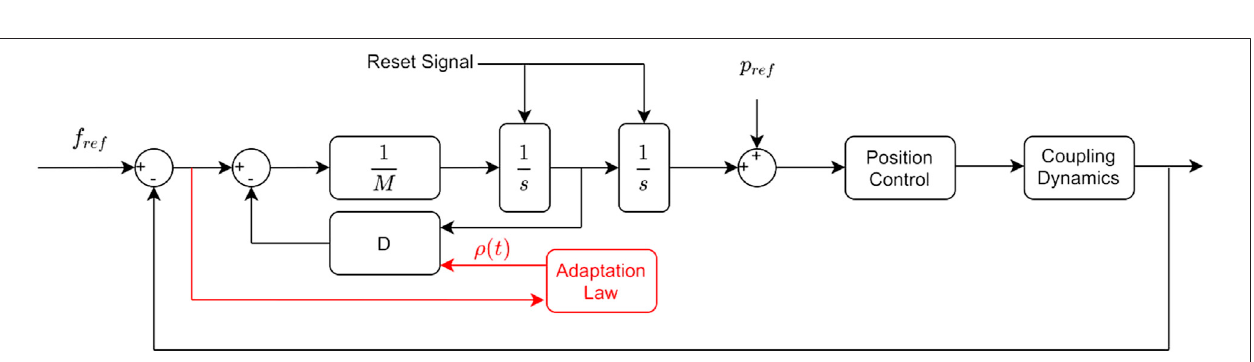
FIGURE 4 | AC diagram (black) and DAAC diagram which shares the same control structure, but with an additional adaptation law (red).